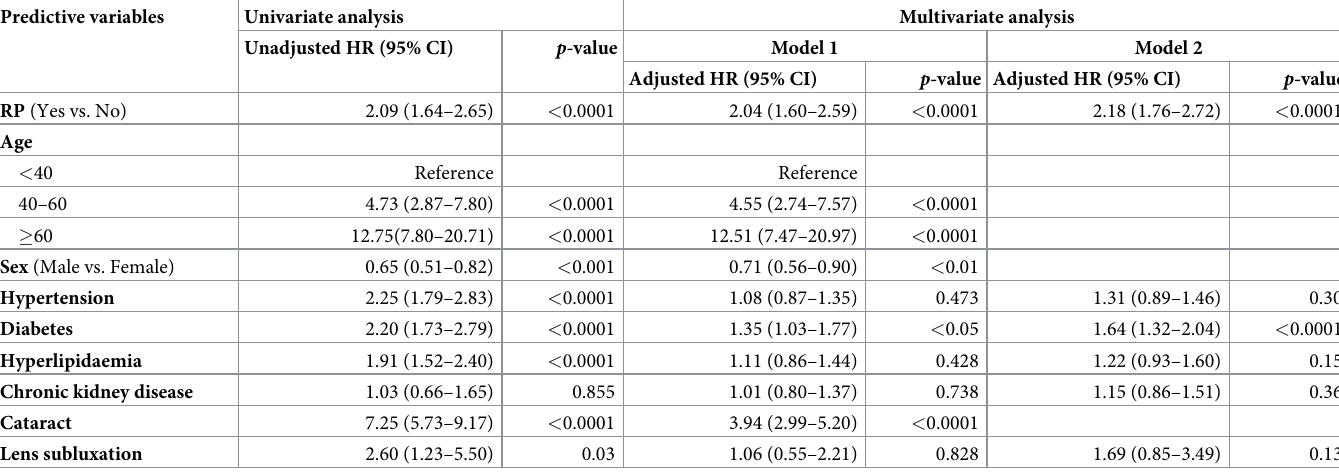
Table 2. Analyses of risk factors for PACG in patients with and without